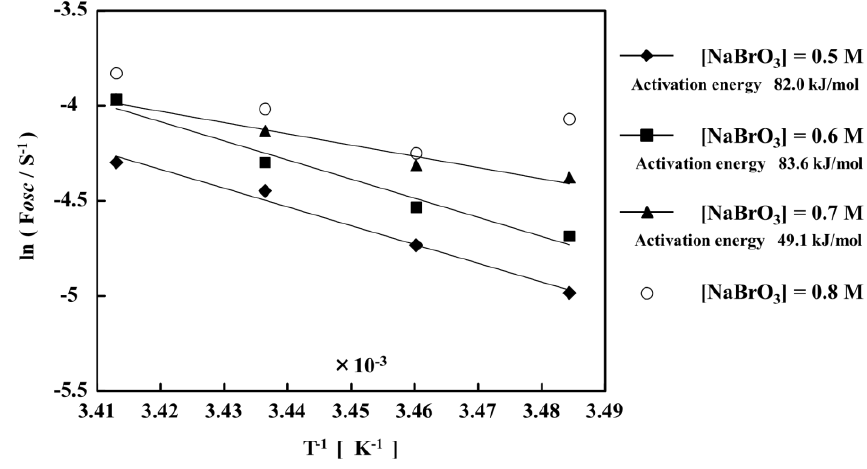
Figure 15. Period of the self-oscillation of the poly(AM- co -Ru(bpy) a function of temperature (14–20 °C) at fixed concentrations of sodium bromate and malonic acid ([NaBrO ] = 0.3 M and [MA] = 0.1 M) and different nitric acid 3 concentrations ([HNO ] = 0.3, 0.4, and 0.5 3